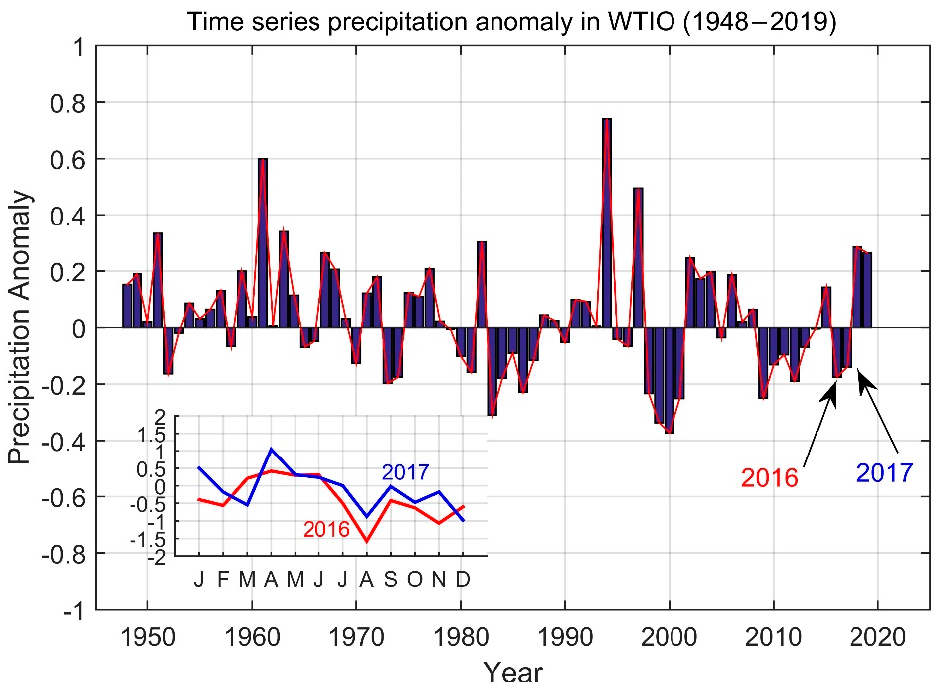
Figure 12. As in Figure 11, but for WTIO region.